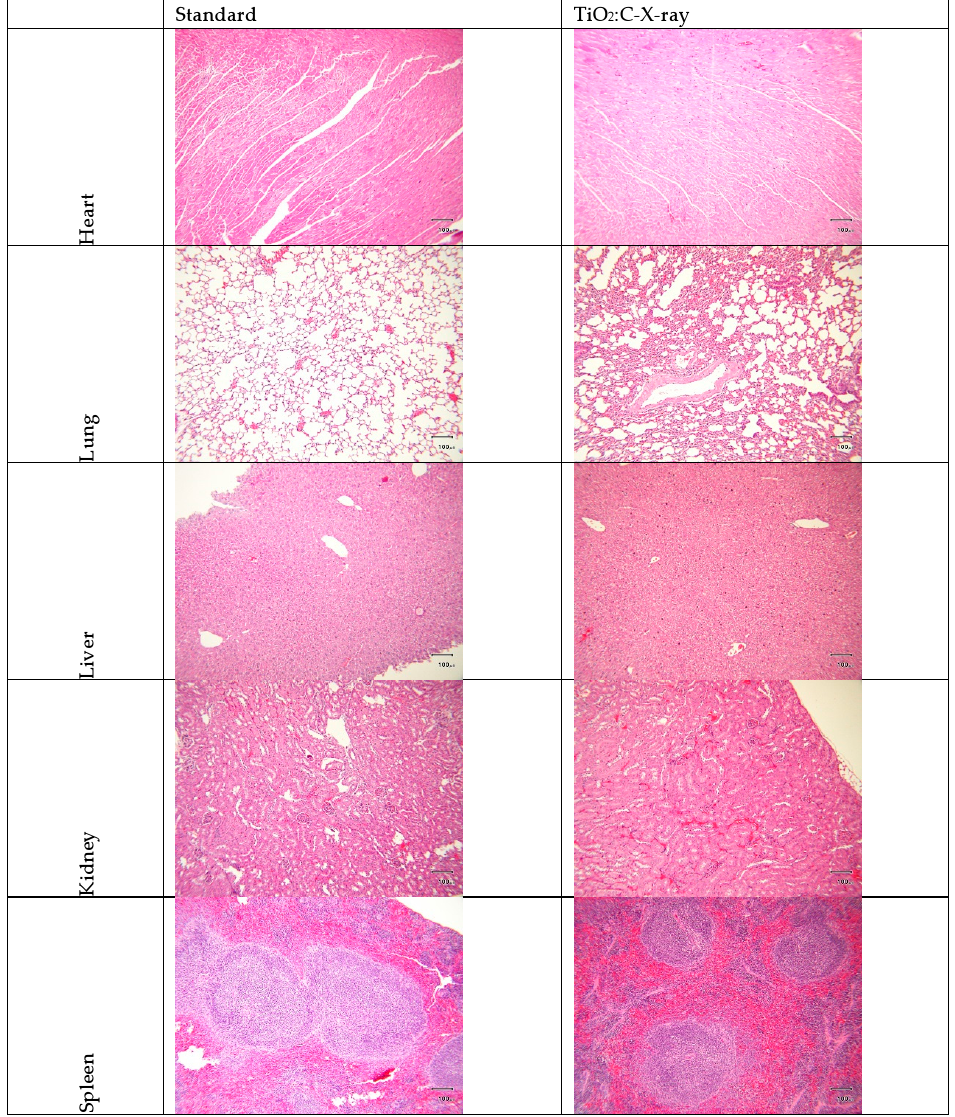
Figure 7. Hematoxylin and Eosin (H-and-E)-stained slices of major organs harvested from scarified BALB/c nude mice at the end of the animal study and examined under optical microscope (scale bar: 100 μ m). Table 1. Bio-chemical analysis of the blood/serum samples from the TiO 2 :C-X-ray group.